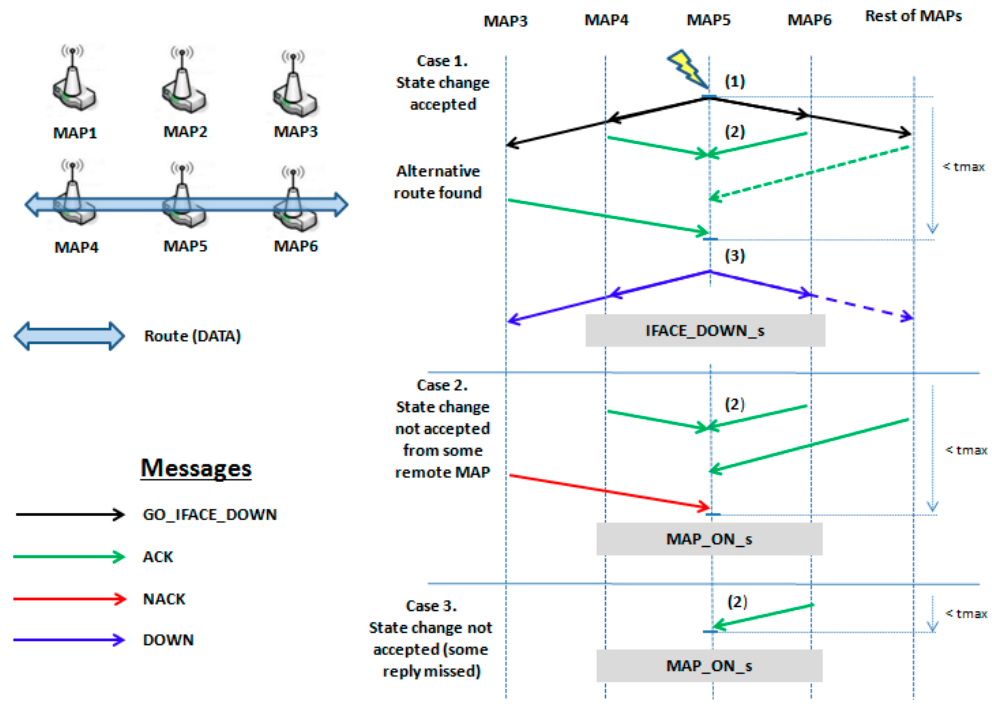
Figure 6. Sequence of messages and state changes for MAP5.